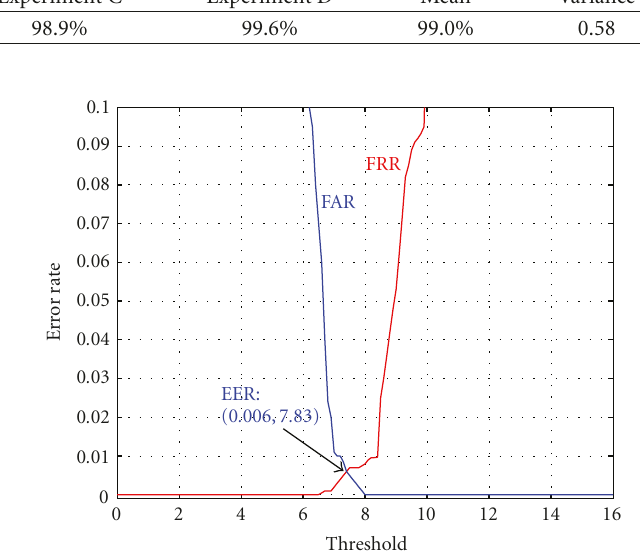
Figure 13: Intersection of FRR and FAR diagram shows EER for Experiment A with α = 1 . 7.